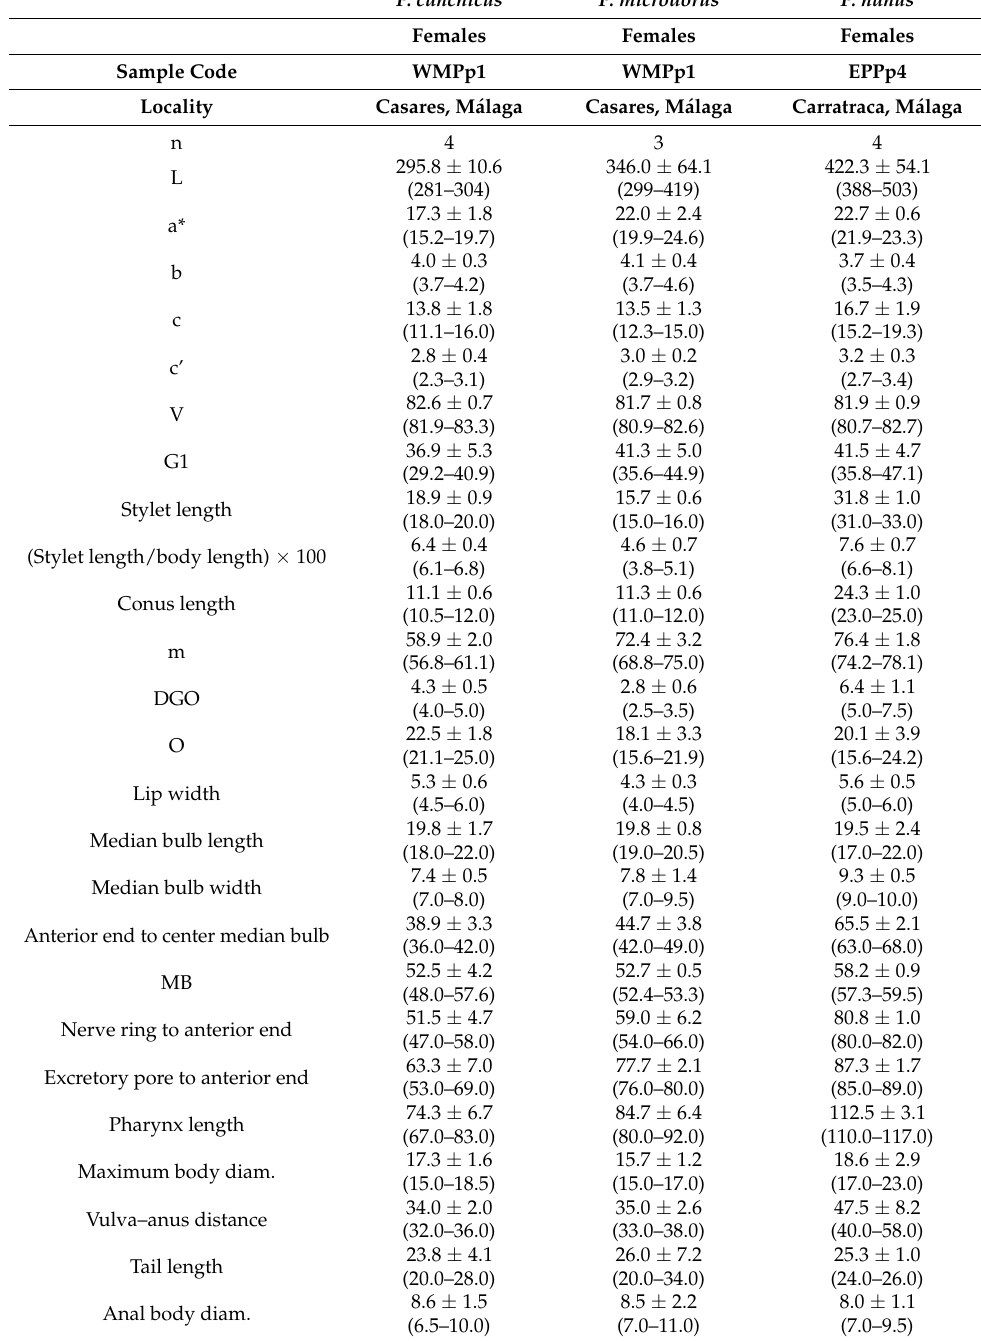
Table 4. Morphometrics of Paratylenchus canchicus Mohilal and Dhanachand, 2004, Paratylenchus microdorus Andr á ssy, 1959, and Paratylenchus nanus Cobb, 1923 females. All measurements are in µ m and in the form: mean ± s.d.